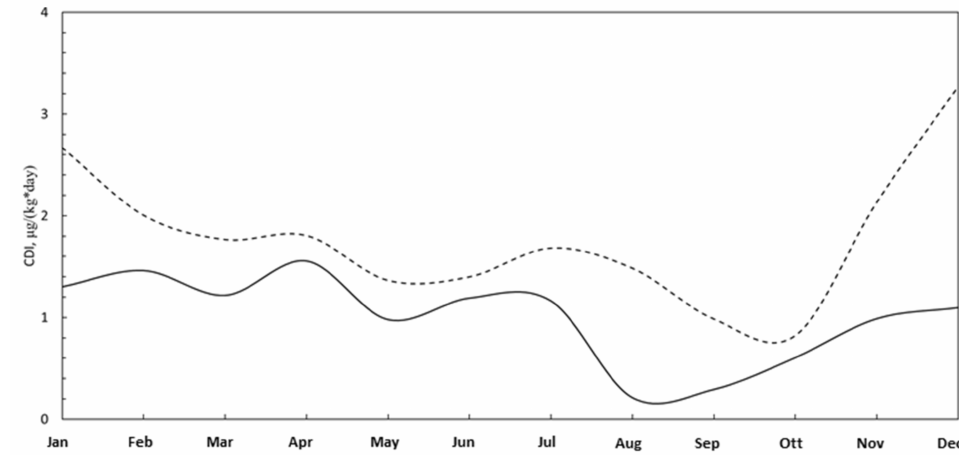
Figure 11. Cadmium (Cd) CDI for the HI (solid grey line) and LI (dashed grey line) area for every month in